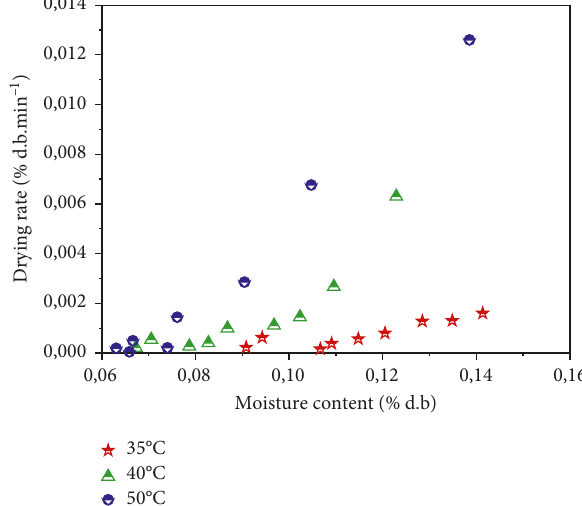
Figure 4: Evolution of drying rate versus moisture content for three temperatures of Crocus sativus